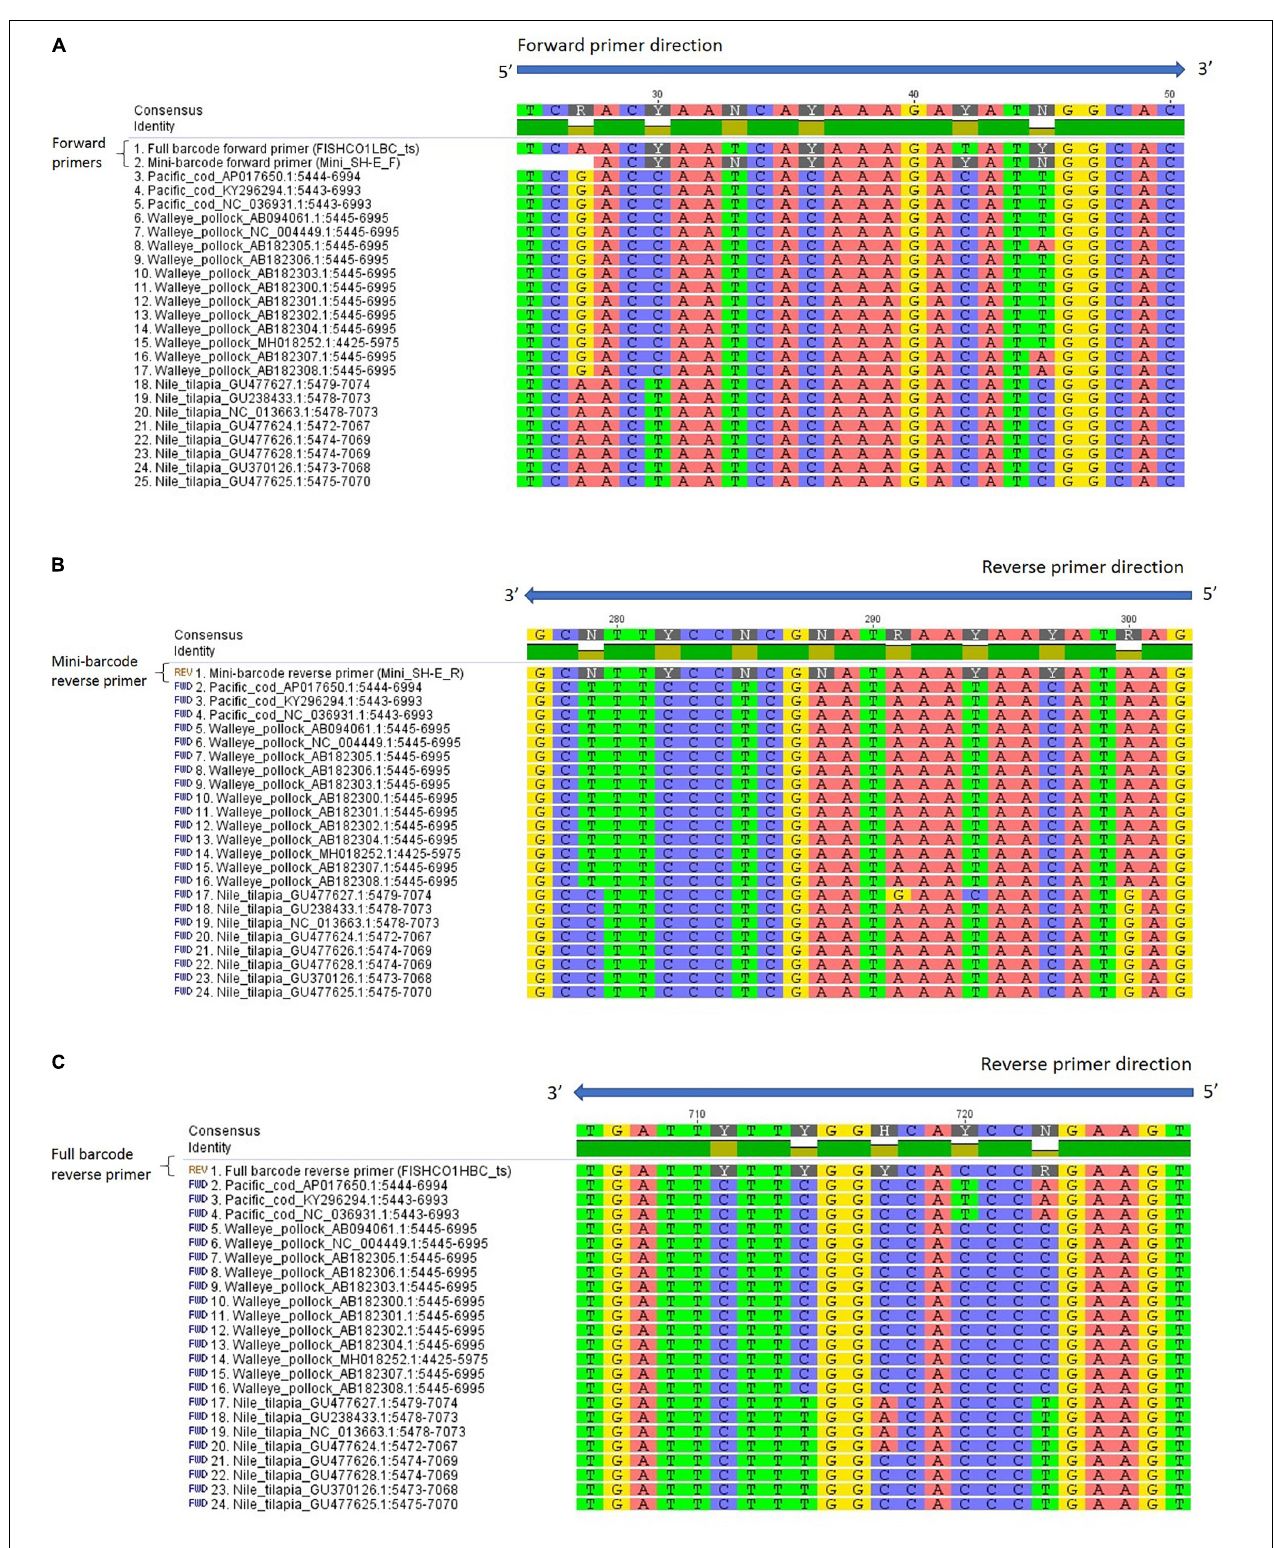
FIGURE 1 | Reference sequences from GenBank aligned with (A) mini SH-E and full-barcode forward primers, (B) mini SH-E reverse primer (reverse complement), and (C) full barcode reverse primer (reverse complement). The sequences were aligned in Geneious using MUSCLE and are shown in the 5 (cid:48) to 3 (cid:48) orientation. Primers are shown without the M13 tails and inosine is represented by an “N” in the primer sequence.